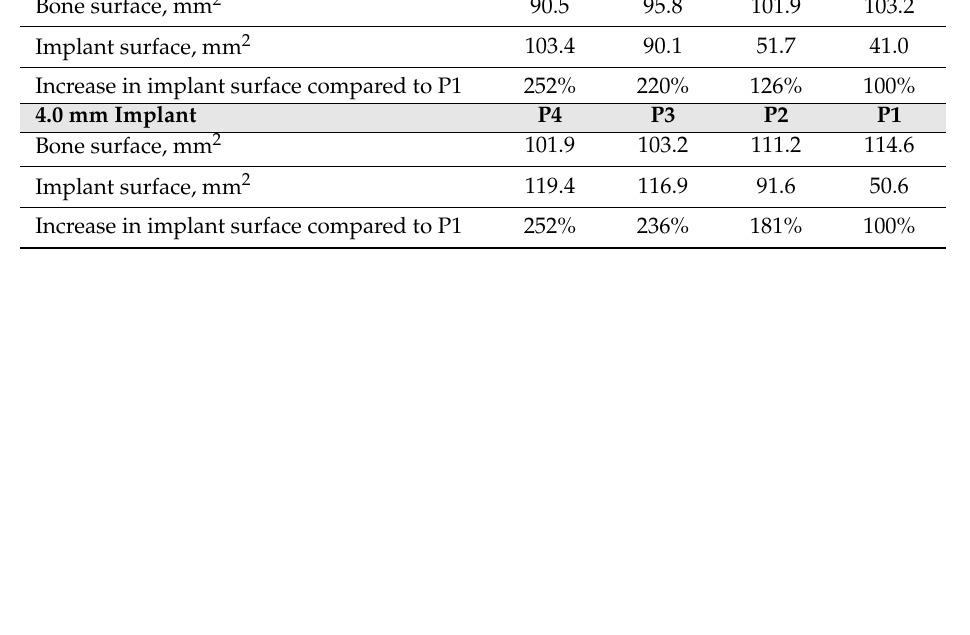
Figure 3. Surface morphology of area of the implant in contact with the bone, and the diameter in each site preparation for 4.0 mm diameter implants.